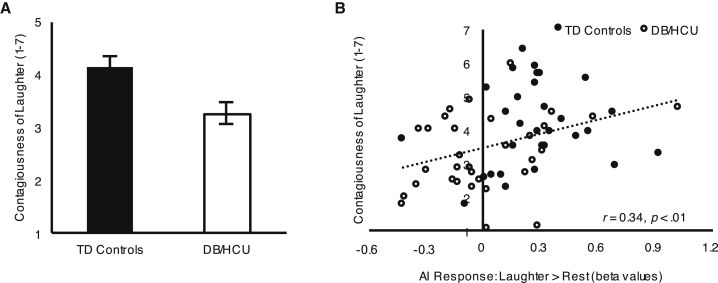
Group Differences on Perceived Contagiousness of Laughter and Relationship with Neural Responses in the Anterior Insula(A) Behavioral data on reported desire to join in with genuine laughter for TD versus DB/HCU boys (significant group difference: t(61) = 3.02, p < 0.01). Error bars represent the standard error of the mean.(B) Anterior insula response for genuine laughter versus rest (beta values extracted from a 10-mm sphere around the peak of the cluster) plotted against reported desire to join in with genuine laughter across TD and DB/HCU boys.